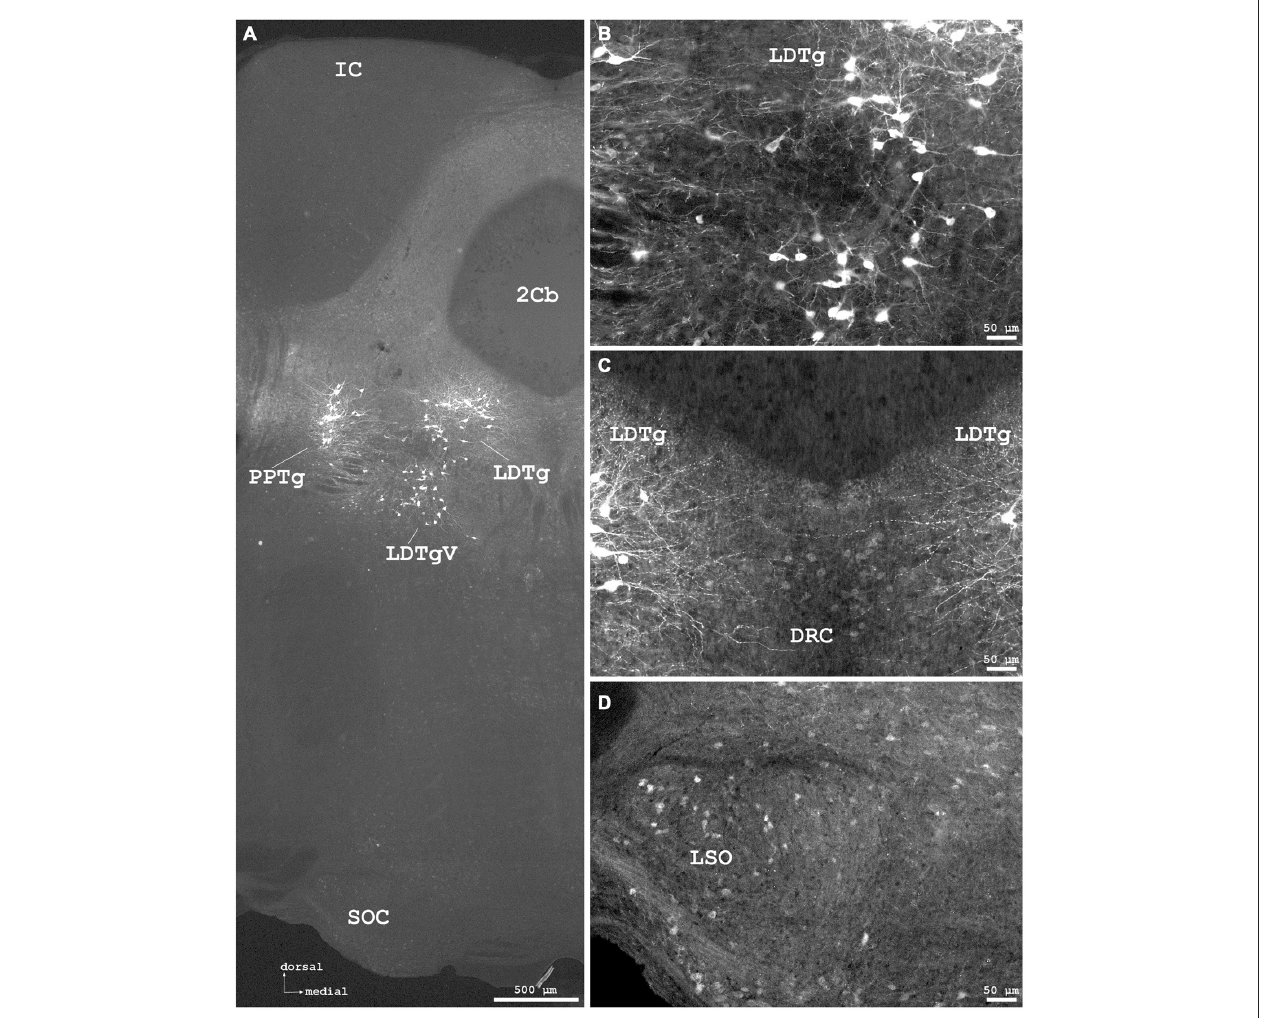
FIGURE 7 | Cygb-immunofluorescence in a frontal section of the mouse brain at the levels of approximately interaural − 1.0 to − 1.3 mm, corresponding to Figures 71–73 of the mouse brain atlas. (A) Low power photomicrograph (MIA) showing the inferior colliculus (IC), cerebellar lobule 2 (2Cb), tegmental nuclei and the superior olivary complex (SOC). (B) Higher magnifications “extended focal imaging” (EFI) demonstrating Cygb-IR neurons in the laterodorsal tegmental nucleus (LDTg), in its ventral part (LDTgV) and in the PPTg. (C) LDTg nucleus neurons and fibers crossing contralaterally EFI. Note the light staining of neurons in the caudal part of dorsal raphe neurons (DRC). (D) Some neurons in the lateral superior olivary nucleus (LSO) were